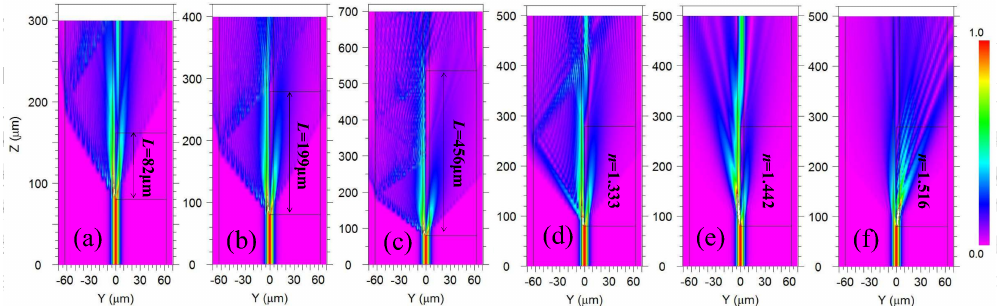
Figure 3. Simulated electric field intensity evolution for light propagating through the MCMZIs when the cavity length is ( a ) 82 µ m; ( b ) 199 µ m; and ( c ) 456 µ m in air, and when ambient RI is ( d ) 1.333; ( e ) 1.442; and ( f ) 1.516 for the cavity length 199 µ